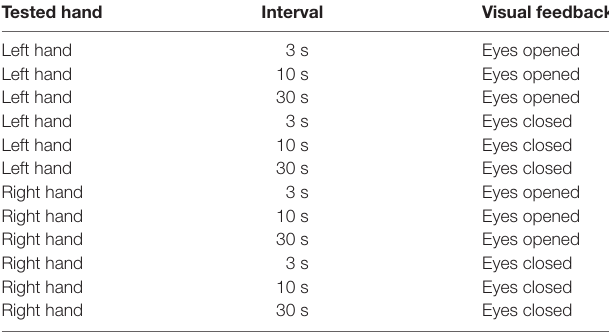
TABLE 1 | Twelve trial